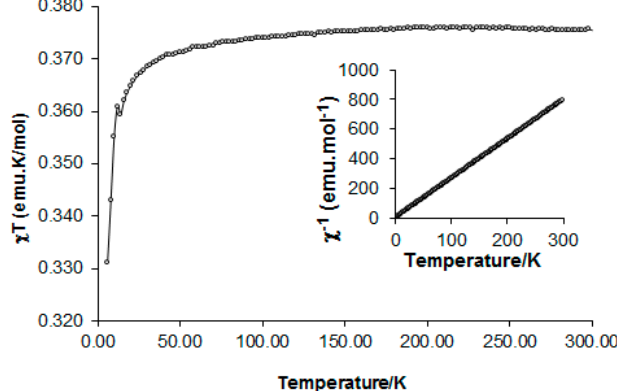
Figure 5. Temperature dependence of χ T upon heating from 5 to 300 K. Inset: Curie-Weiss behavior, C = 0.377 emu K·mol − 1 and θ = − 0.61 K.